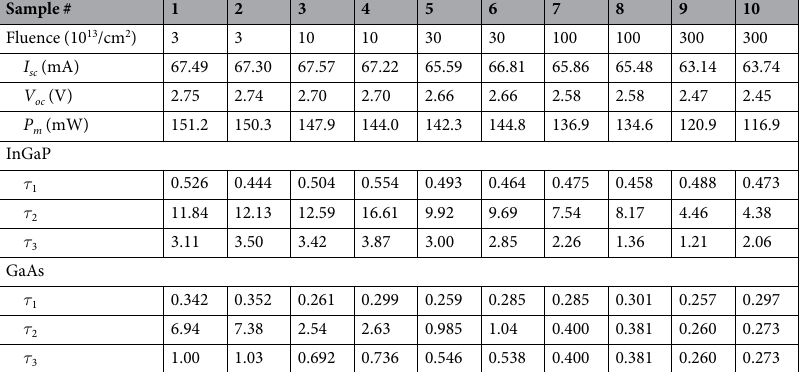
Table 1. Overview of samples. The table shows the irradiation fluence for each sample, and the final I–V parameters and PL decay time constants for the InGaP and GaAs subcells after irradiation.